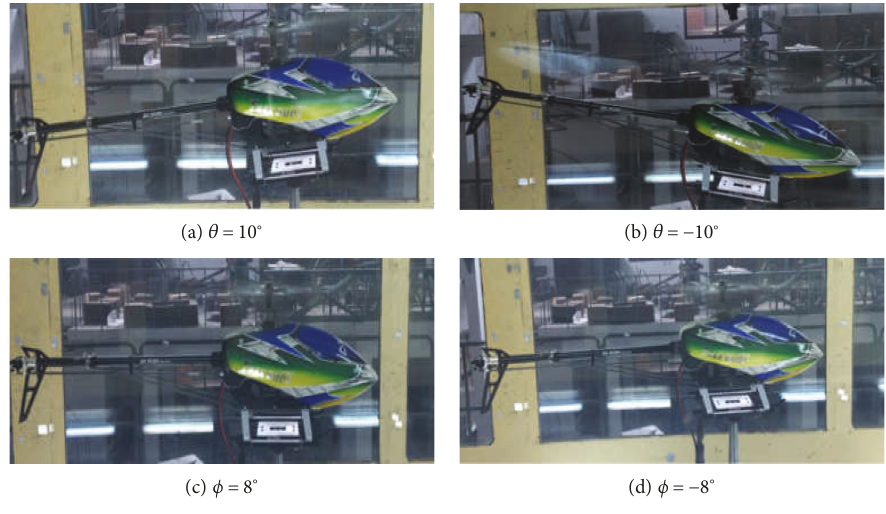
Figure 11: Blow air test of the full helicopter.